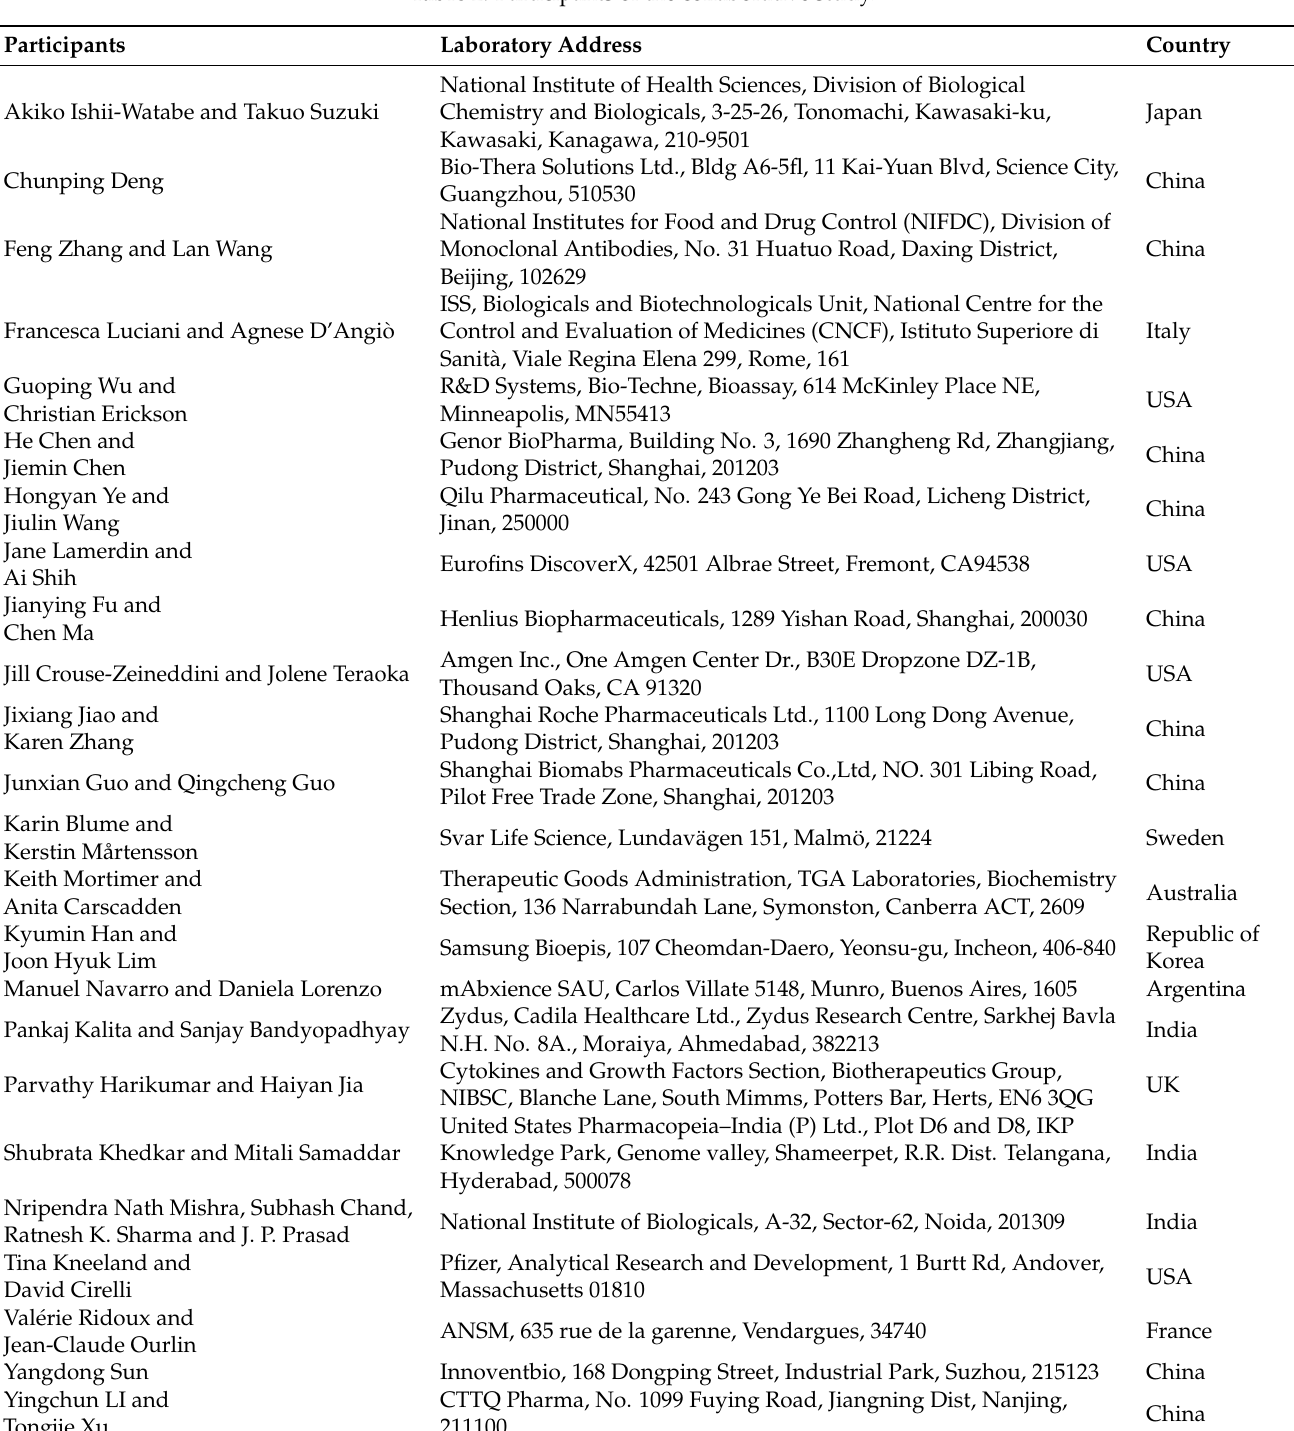
Table 2. Participants of the collaborative